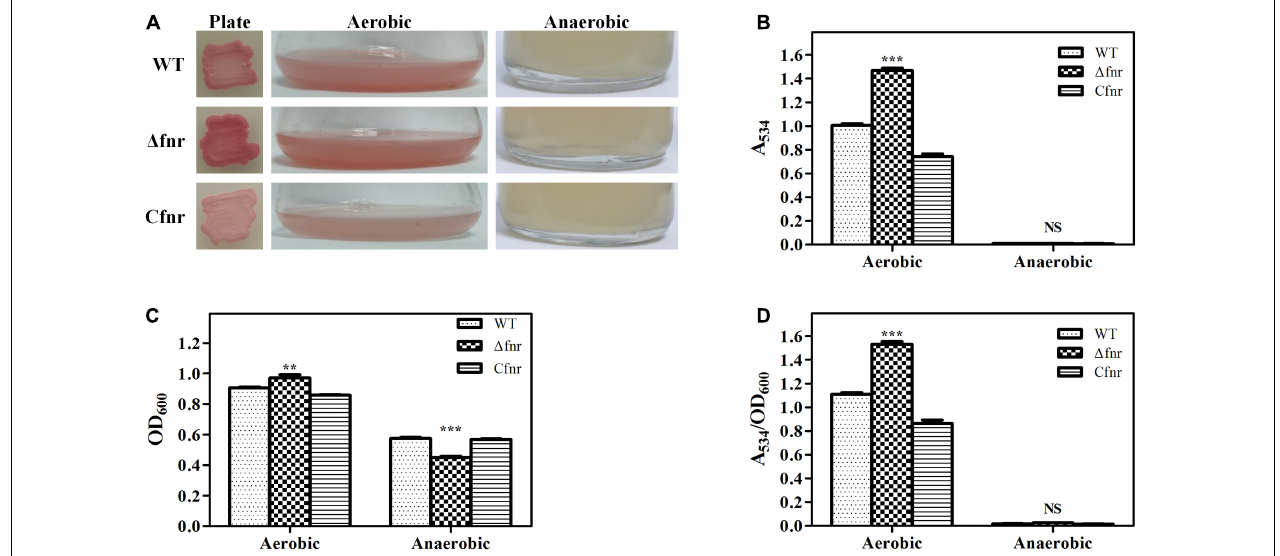
FIGURE 1 | Effect of Fnr on cell growth and prodigiosin production in Serratia sp. ATCC 39006. (A) Colonies, aerobic fermentation broth, and anaerobic fermentation broth of WT, (cid:49) fnr , and C fnr . Prodigiosin production (B) , cell growth (C) , and prodigiosin yield per cell unit (D) of WT, (cid:49) fnr , and C fnr during aerobic and anaerobic fermentation. Experiments were performed at least three times, and data are shown as the mean ± standard deviation (SD). Student’s t -test was used to analyze the statistical significance (NS, no significance; ** p < 0.01, *** p <